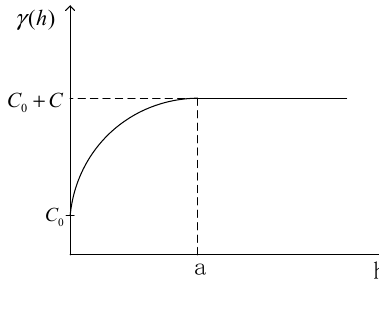
Figure 3. The ideal variogram curve.